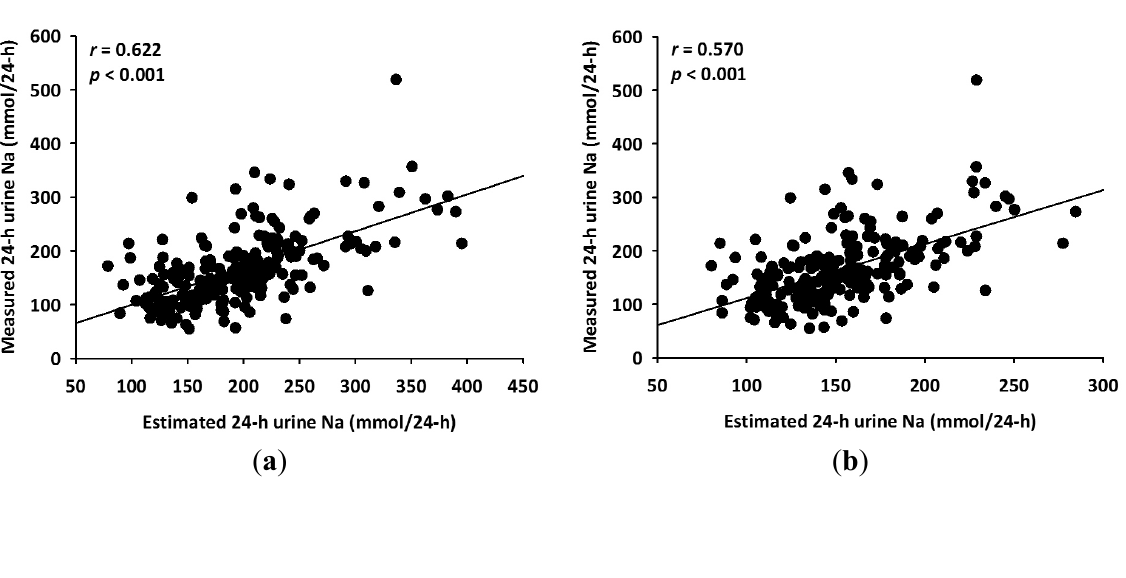
Figure 3. Relationship between measured and estimated 24-hour urine sodium obtained by six equations. ( a ) Kawasaki’s equation; ( b ) Tanaka’s equation; ( c ) INTERSALT equation; ( d ) linear equation; ( e ) quadratic equation; and ( f ) cubic